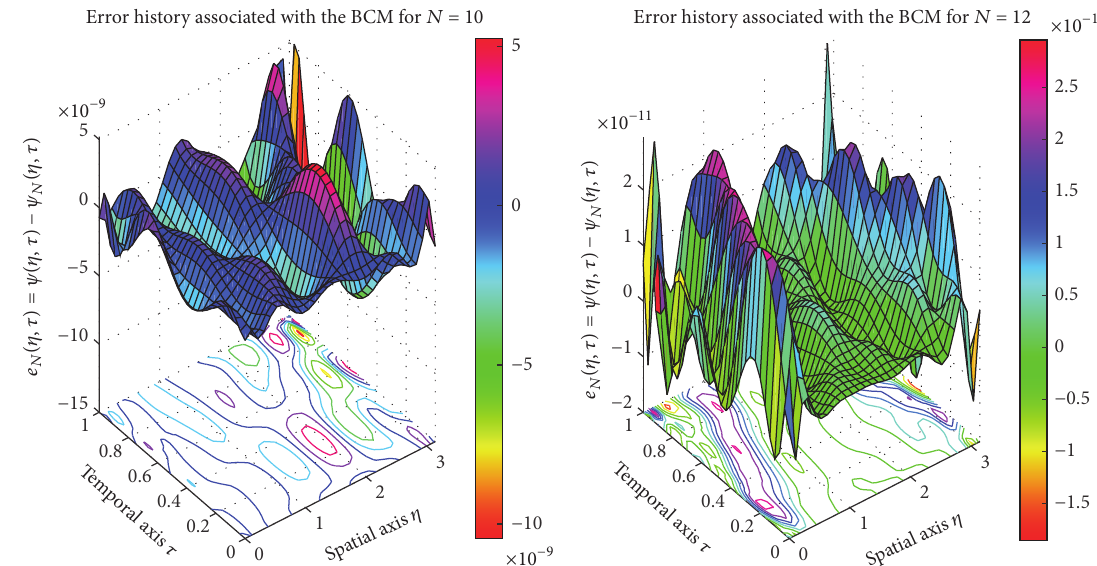
Figure 8: Error histories associated with the obtained numerical solution of the second example for 𝑁 = 10, 12 .